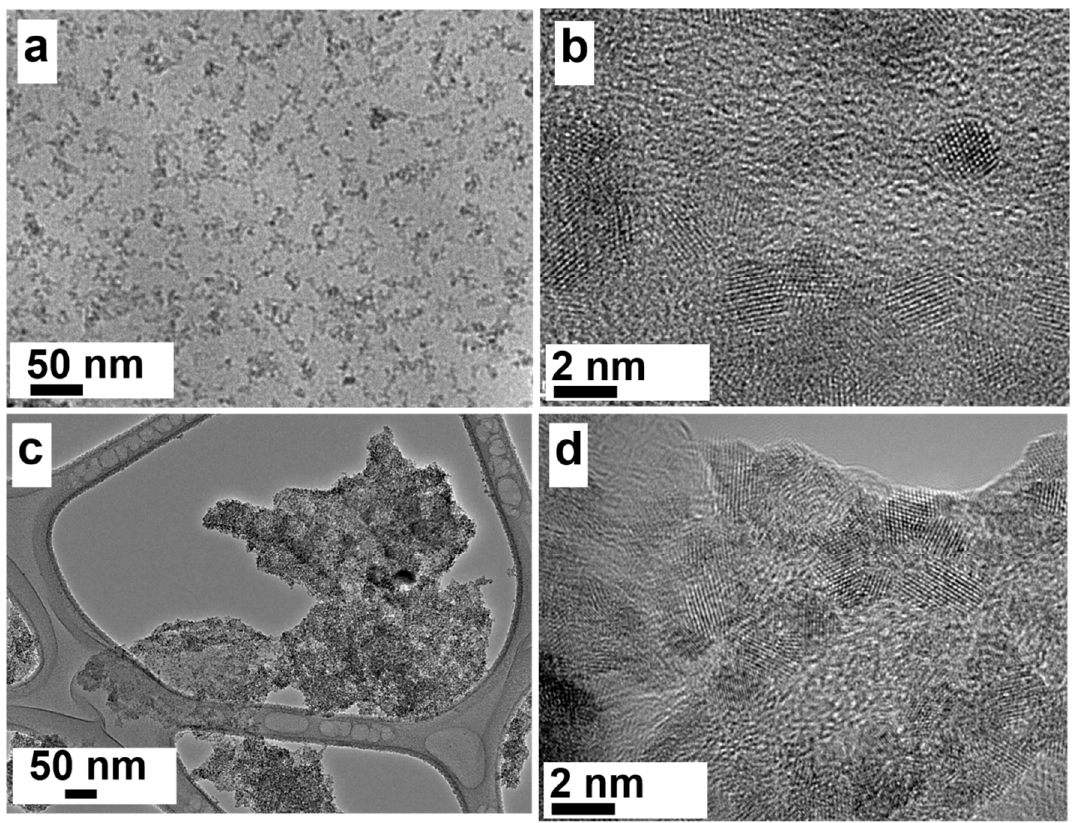
Figure 2. TEM images of pure ZrO 2 NPs ( a , b ), and HRG@ZrO 2 nanocomposite ( c , d ). Variation in the reaction conditions has led to the synthesis of ultra-small ZrO 2 NPs.